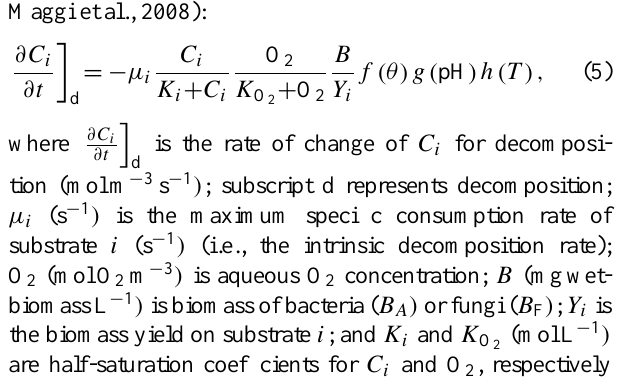
(Table 2). The functions f (θ) , g (pH), and h (T ) describe